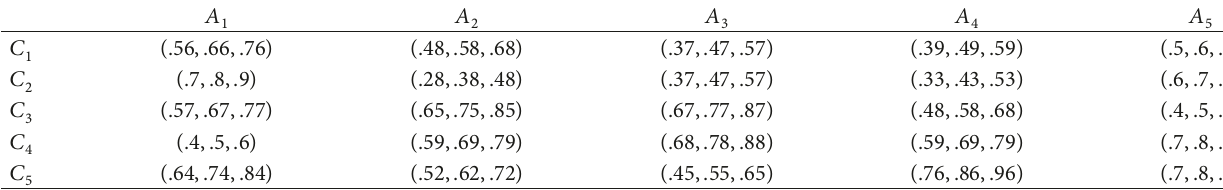
Table 4: Fuzzy payoff matrix.